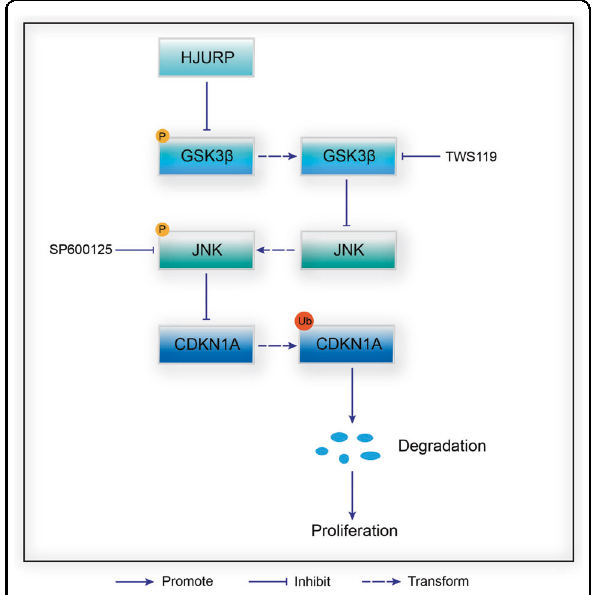
Fig. 6 Mechanisms of HJURP in PCa cells. HJURP inhibits the phosphorylation of GSK3 β S9 and JNK T183/Y185, which activates the ubiquitin-dependent proteasomal degradation pathway of CDKN1A and ultimately promotes the proliferation of PCa cells. P phosphorylation, Ub